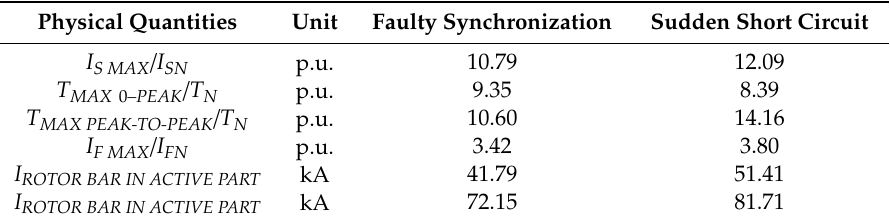
Table 5. Comparison of maximum values of physical quantities existing during faulty synchronization and sudden short